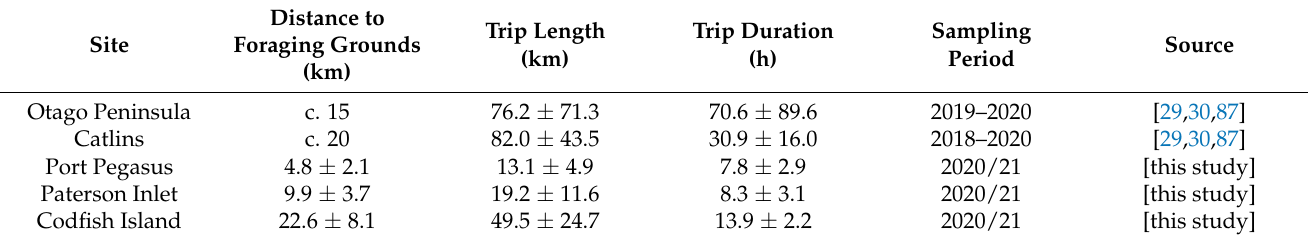
Table 3. Mean ± SD of distances to foraging grounds (foraging radii) and trip lengths of yellow-eyed penguins breeding on South Island (North Otago, Otago Peninsula, Catlins) and Stewart Island (Port Pegasus, Paterson Inlet, Codfish